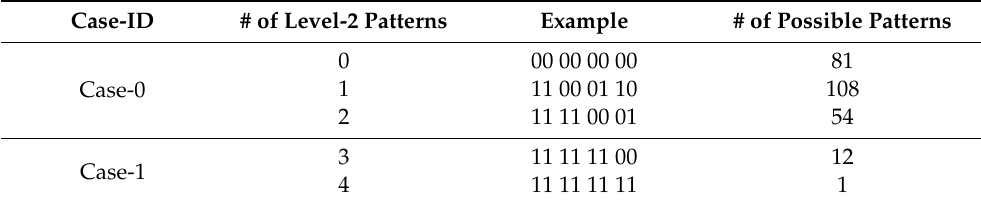
Table 4. Pattern-aware case classification of 8-bit encoding block.